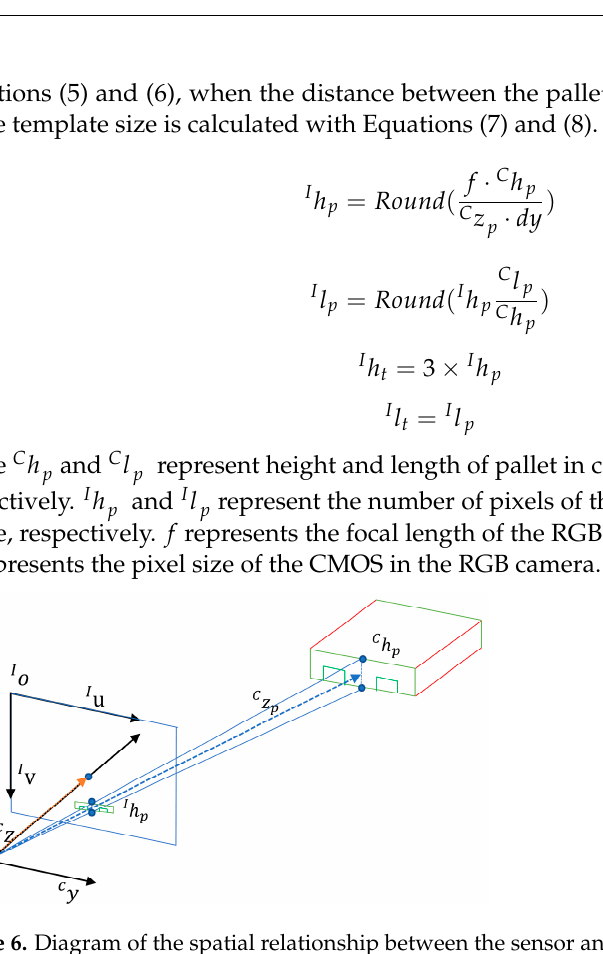
Figure 6. Diagram of the spatial relationship between the sensor and the pallet.